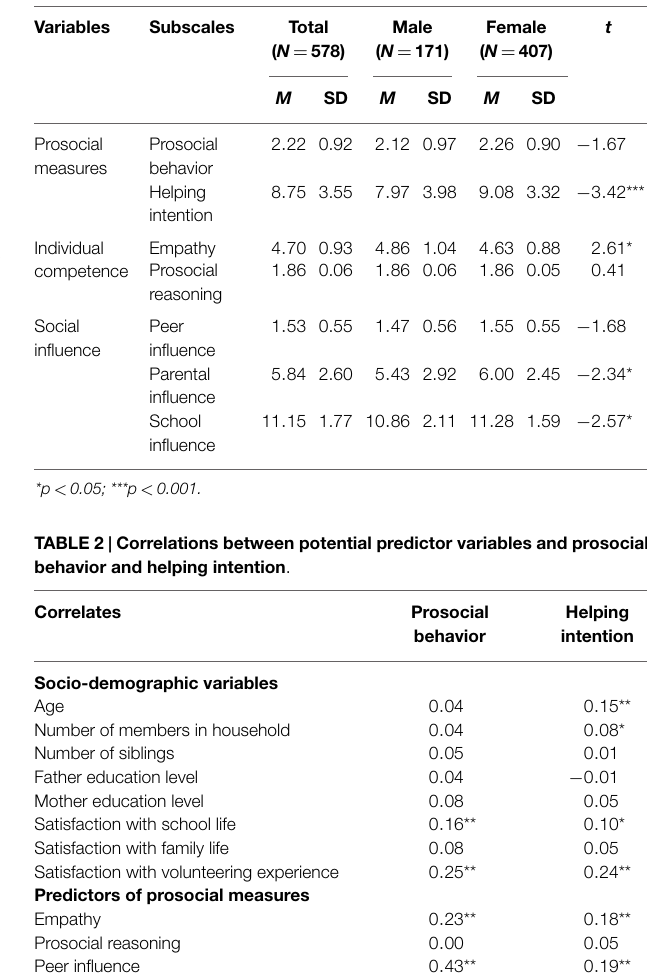
TABLE 1 | Summary statistics of prosocial behavior and the hypothesized individual and social predictors across gender .